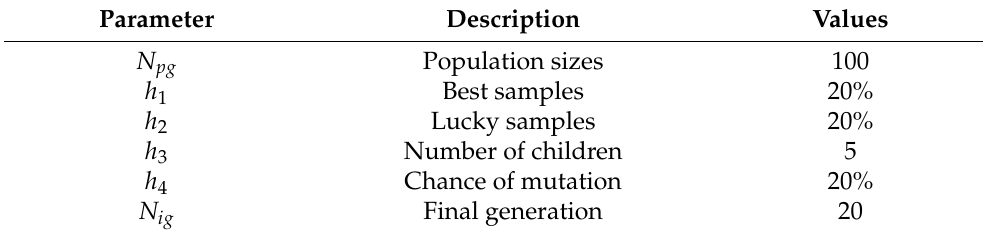
Table 1. Parameters of